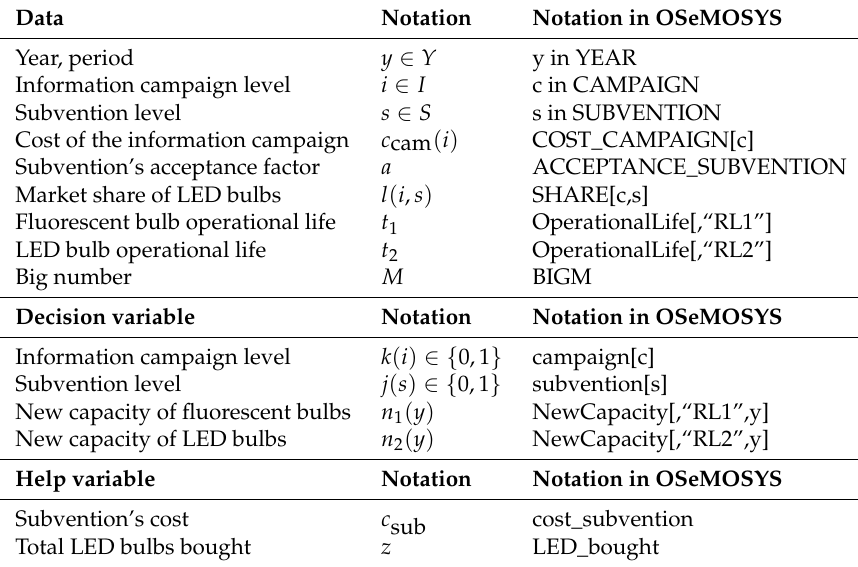
Table 1. Notation for data and